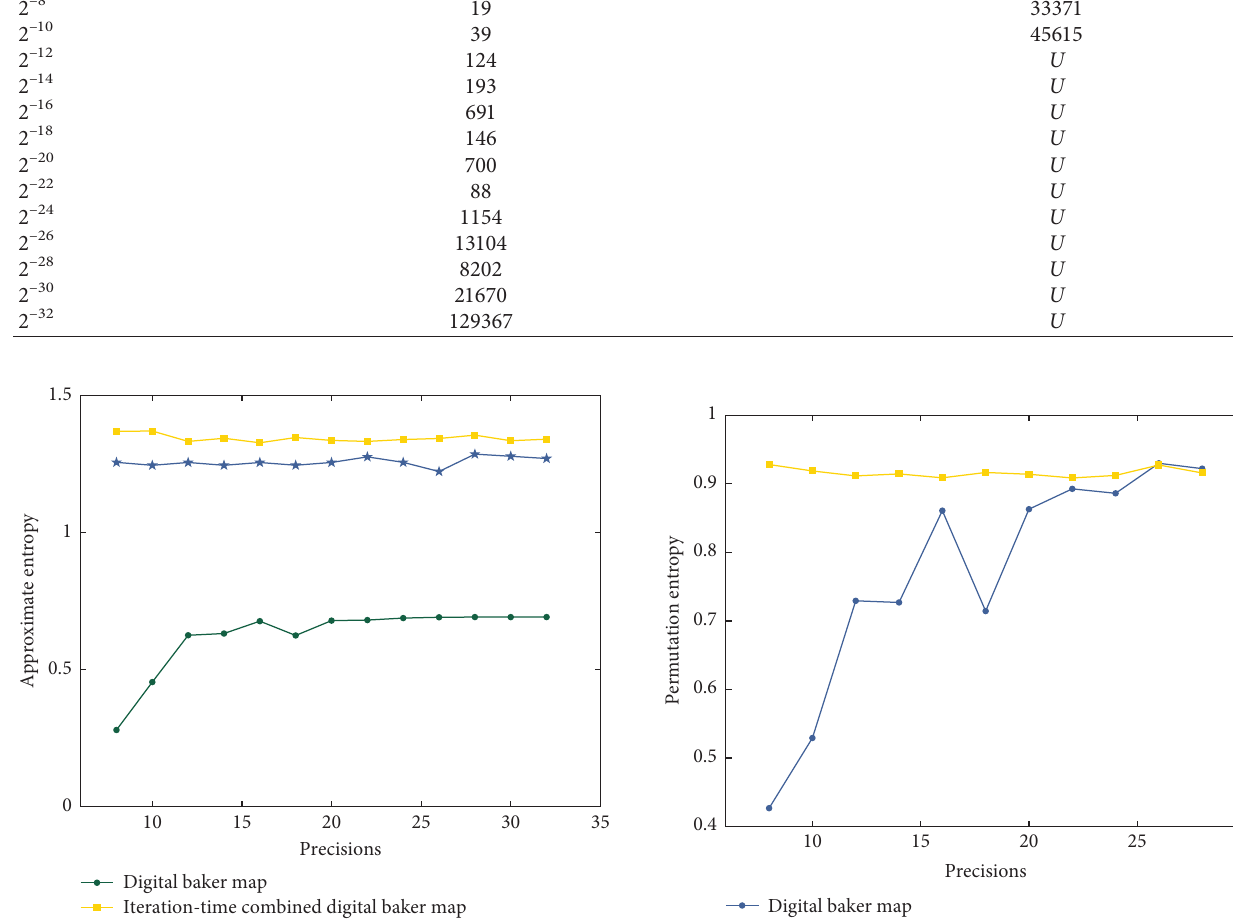
Digital baker map Iteration-time combined digital baker map Coupled baker map in Ref. Figure 9: The ApEn of the digital baker map, iteration-time combined digital baker map, and coupled baker map in [4].